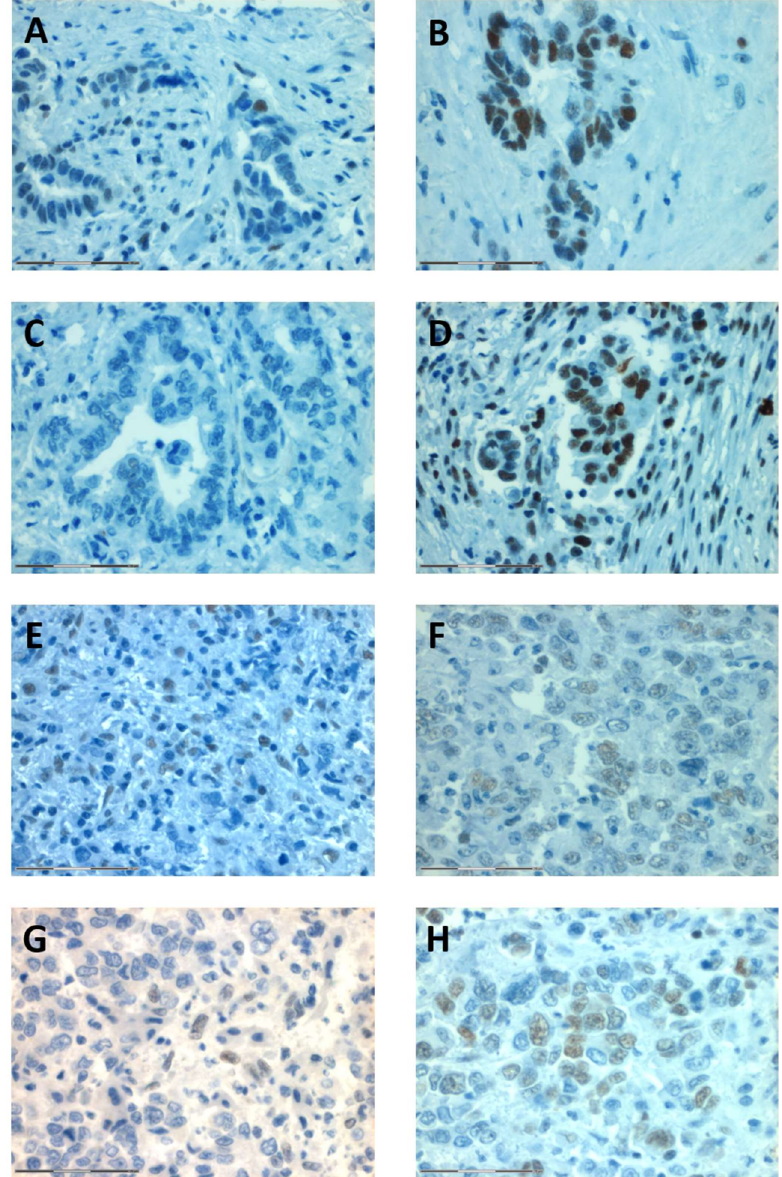
Figure 4. Representative stainings of the patients with MSI-low CCA (Pat ID 121, A – D ) and MSI-high CCA (Pat ID 105, F – H ). In both patients, no loss of expression was found for PMS2 ( A , E ), MLH2 ( B , F ), MLH1 ( C , G ), and MSH6 ( D , H ). Magnification: 40 × , scale bar: 75 µ